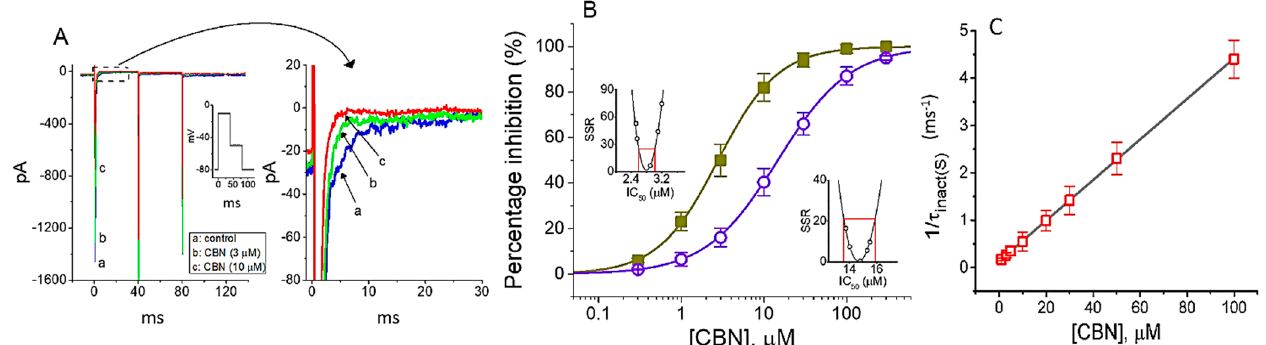
Figure 1. Effect of columbianadin (CBN) on voltage-gated Na + current ( I Na ) in pituitary tumor (GH 3 ) cells. The experiments were undertaken in cells bathed in Ca 2+ -free Tyrode’s solution, and the recording electrode was filled up with Cs + -containing solution. ( A ) Typical current traces obtained in the control (a, i.e., CBN was not present) and in the presence of 3 µM CBN (b) or 10 µM CBN (c). The insert illustrates the voltage protocol applied. The right panel indicates an expanded record from the dashed box of ( A ). ( B ) Concentration-dependent relationship of CBN on peak ( ○ ) and late ( ■ ) components of I Na elicited by rapid membrane depolarization (mean ± SEM; n = 8 for each point). Insets show confidence assessment of best-fit parameter values in the peak and late component of I Na in response to short depolarizing voltage pulse from − 80 to − 10 mV. Red line shown in each inset is placed at parameter value (i.e., IC 50 ) at which the sum of squared residuals (SSR) in the peak or late component of I Na amounts to 21% or 25% respectively, while the parameter range corresponds to the approximate 95% confidence interval. ( C ) The relation of 1/ τ inact(S) (i.e., the reciprocal of the slow component of current inactivation) versus the CBN concentration (mean ± SEM; n = 8 for each point). The value of I Na inactivation was measured as the examined cells were 40 ms depolarized from − 80 to − 10. Forward ( k + 1 *) or backward ( k − 1 ) rate constant, determined from the slope or the y -axis interacept of the interpolated line, was yielded to be 0.0428 ms − 1 µM − 1 or 0.1348 ms − 1 , respectively.